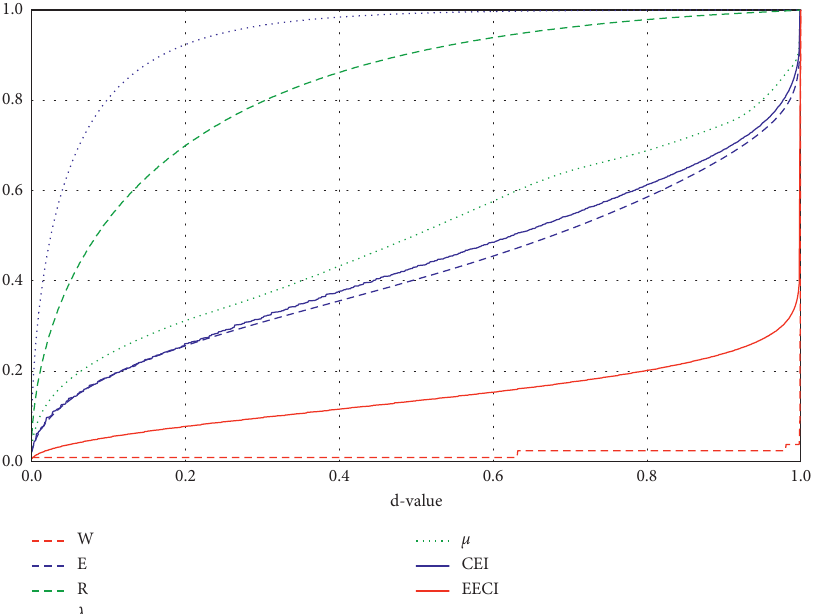
Figure 2: Nonisomorphic tree with 14 vertices.